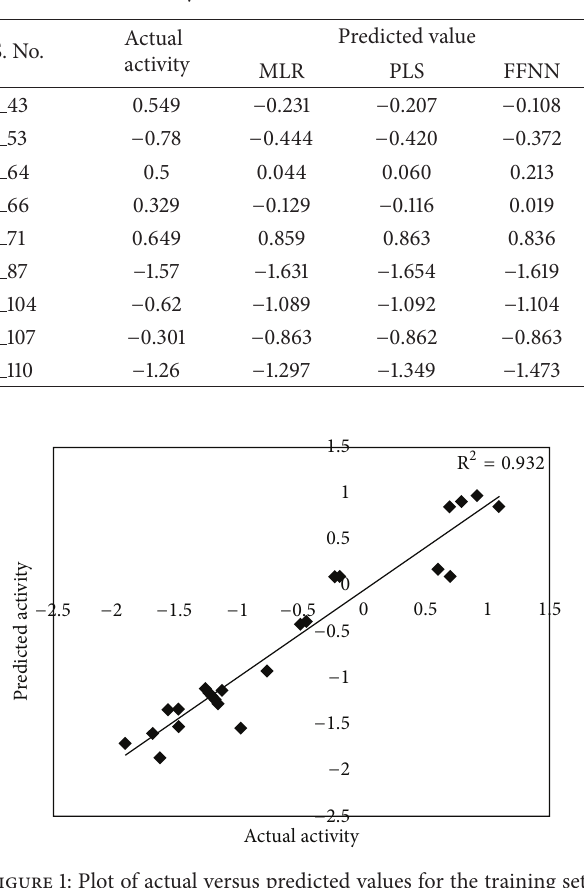
Table 5: Actual and predicted activity data of derivatives obtained from multivariate analysis for training set of breast cell line.